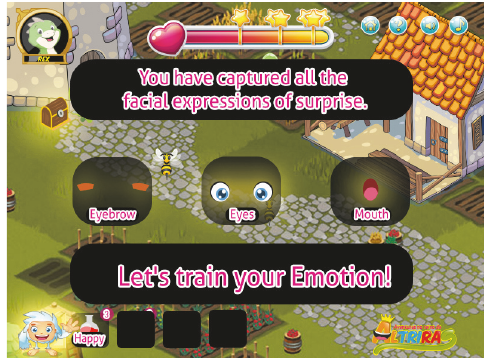
Figure 17: Avatar selection.